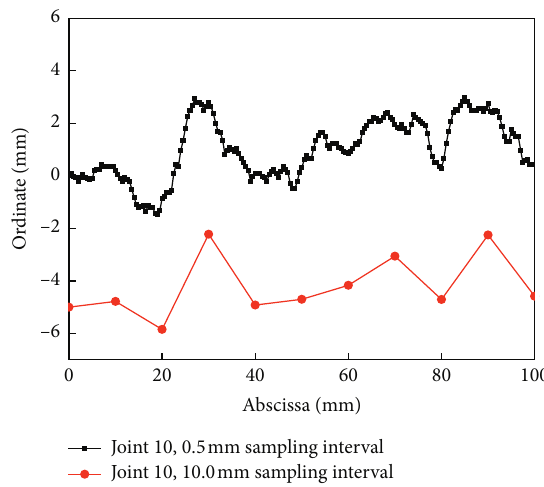
Figure 10: Comparison of the 10th joint profile obtained at 0.5mm and 10mm sampling intervals. Table 6: The estimated JRC values of each joint profile using WPA.